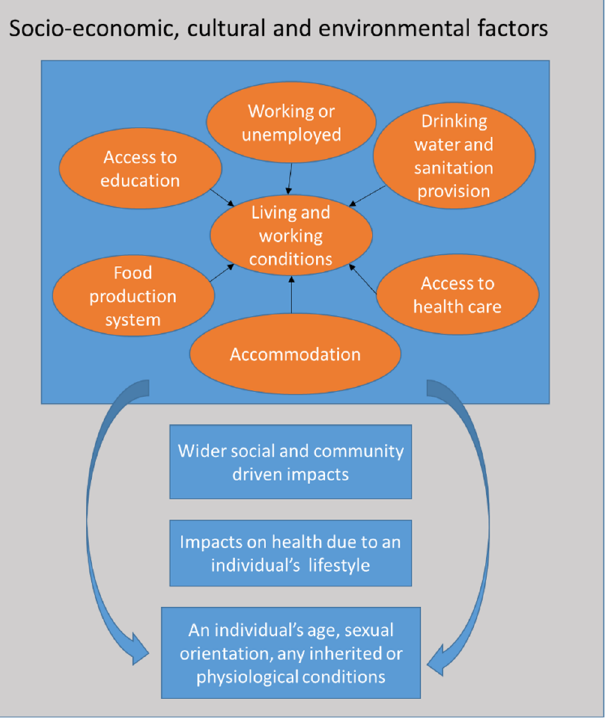
Figure 1. Socioeconomic, cultural, and environmental factors impacting an individual’s health. After Dahlgren and Whitehead, 1991 in [8].